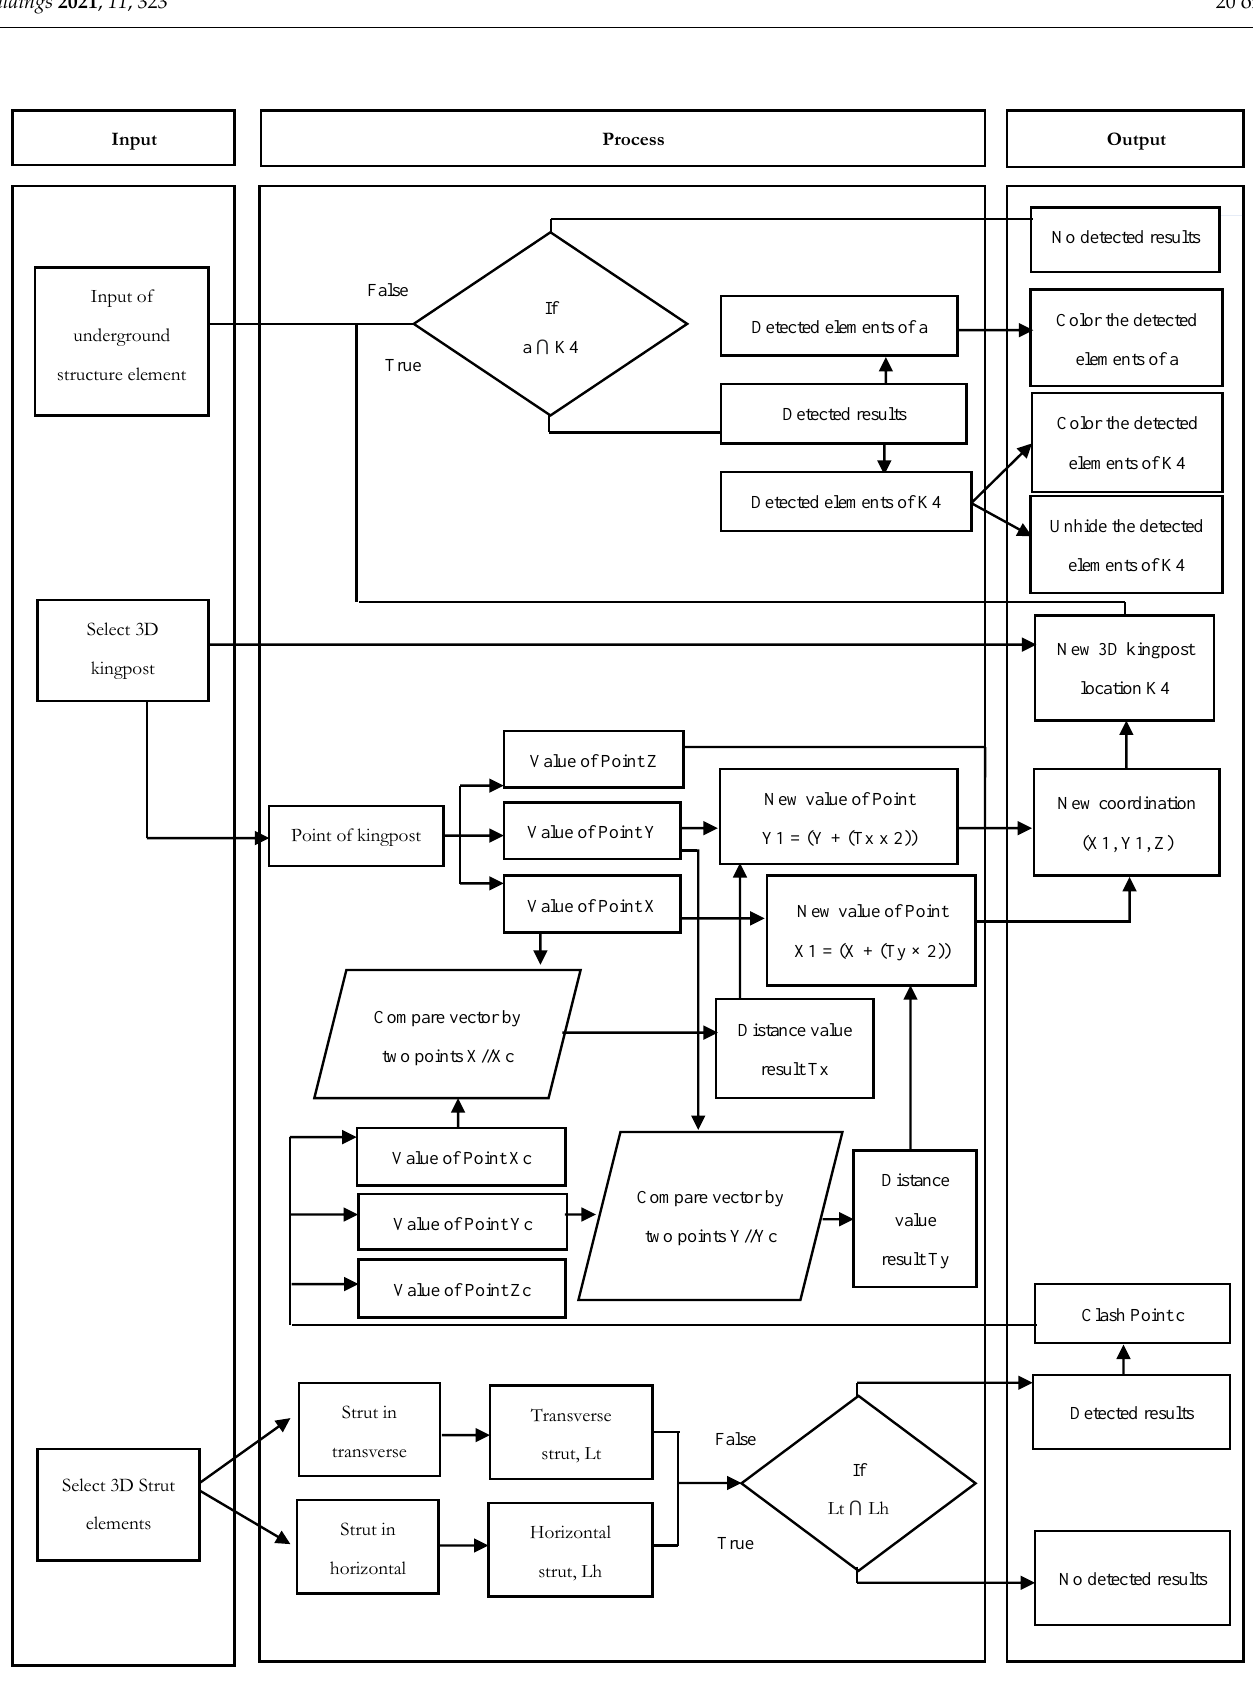
Figure 16. A module of kingpost relocation to the fourth location.